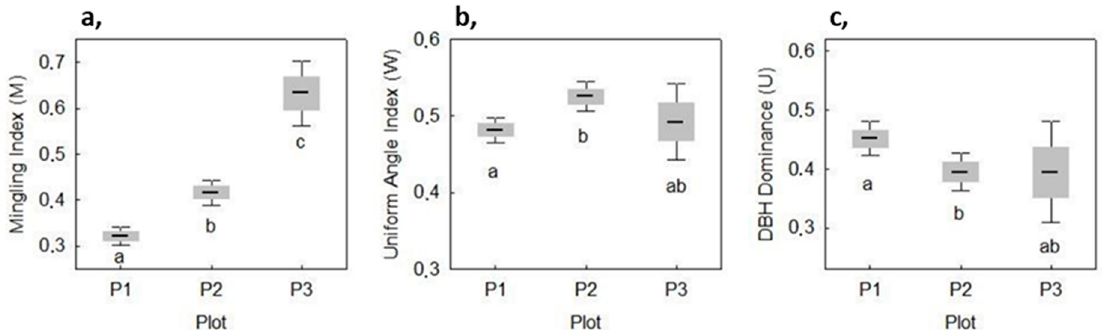
Figure 3. The mingling index ( a ), uniform angle index ( b ), and DBH dominance index ( c ) variation in all three plots. The dashed box indicates mean +/ − standard error of mean and the whiskers are 95% confidence intervals. Different letters indicate significant differences between plots ( p < 0.05; Mann–Whitney U test; non-parametric test).